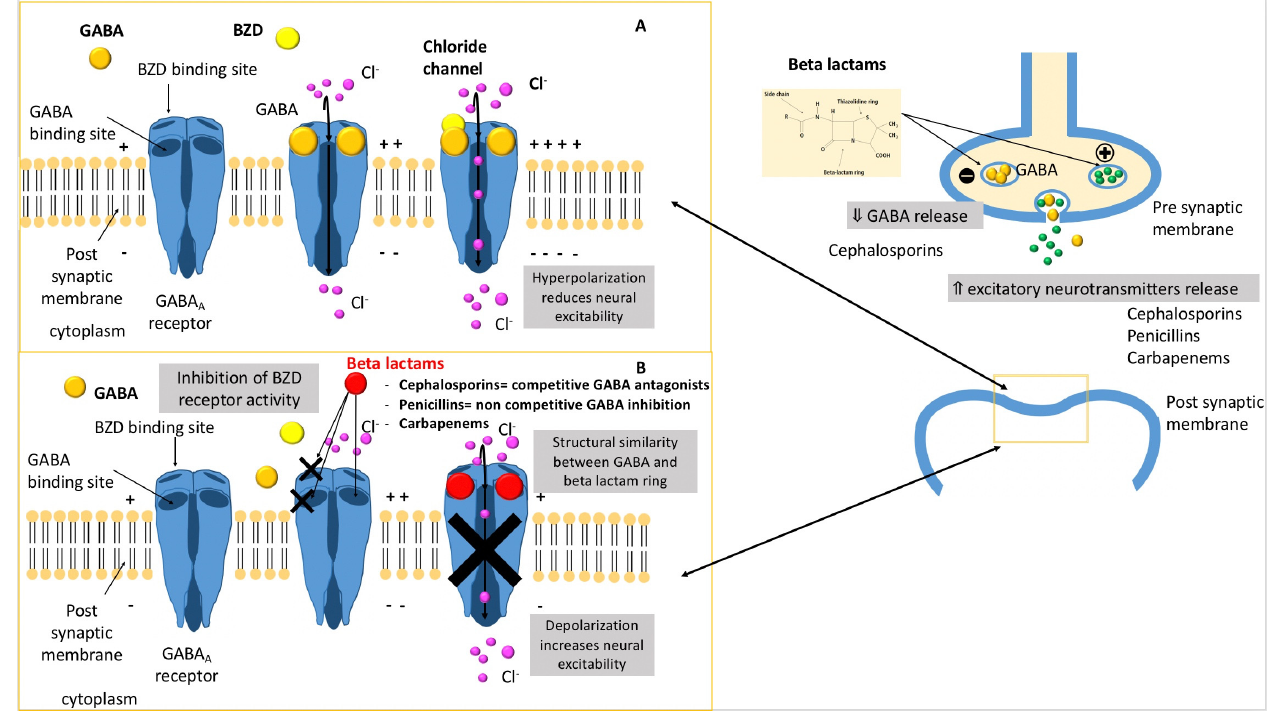
Figure 1. Schematic representation of the different mechanisms involved in beta-lactam-induced neurotoxicity. ( A ) GABA A receptor function, ( B ) beta-lactam neurotoxicity mechanisms.